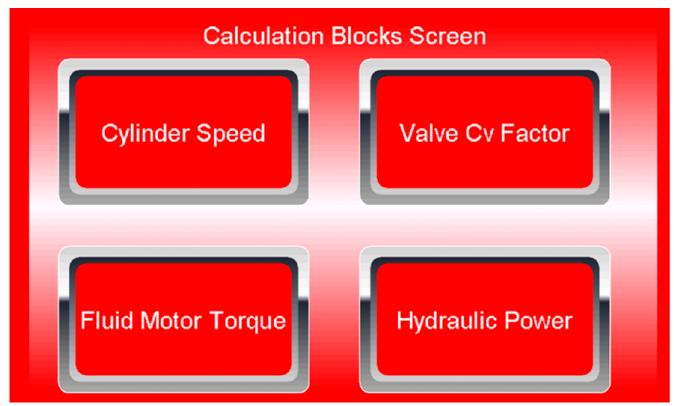
Figure 3. PMD calculation blocks screen.